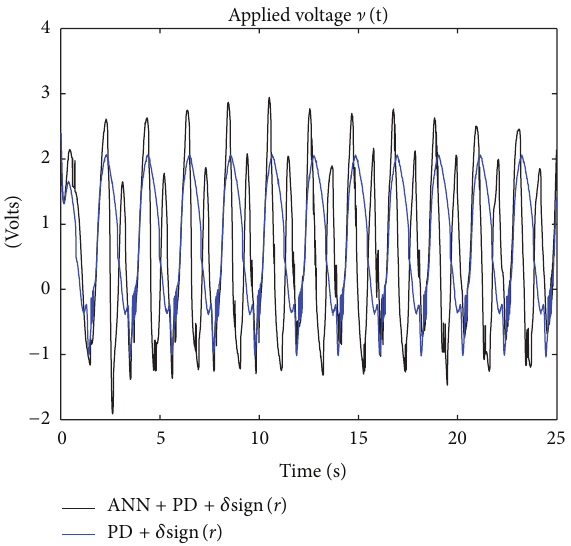
Figure 11: Experiments with the one degree-of-freedom robot: applied voltage V (𝑡) for the PD + 𝛿 sign (𝑟) and the ANN + PD + 𝛿 sign (𝑟) controllers.